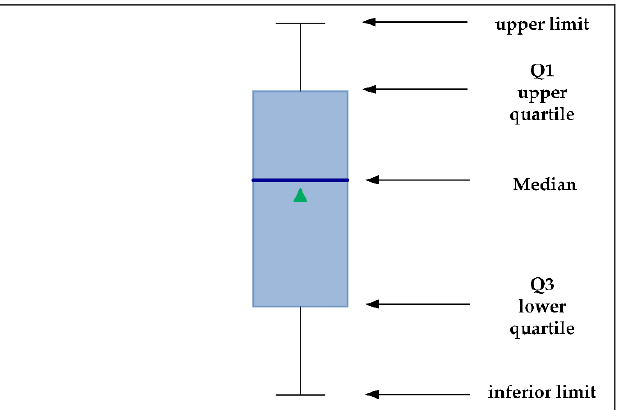
Figure 2. Box plot: the green triangle is the sample median.